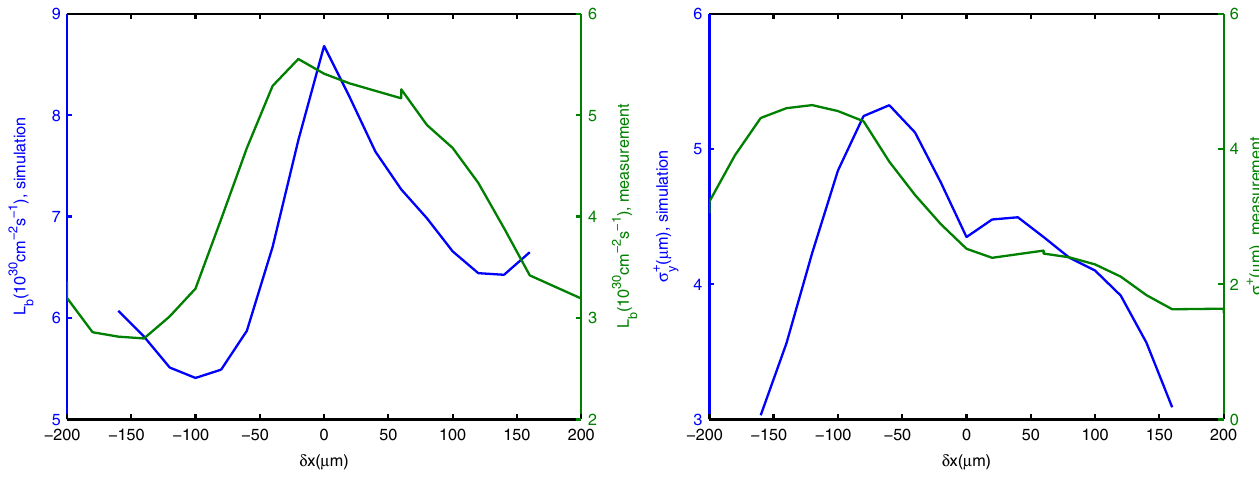
FIG. 12. (Color) Comparison of the simulation with a typical measurement at high beam currents. The figure on the left is the bunch luminosity and the right the vertical size of the positron beam at the